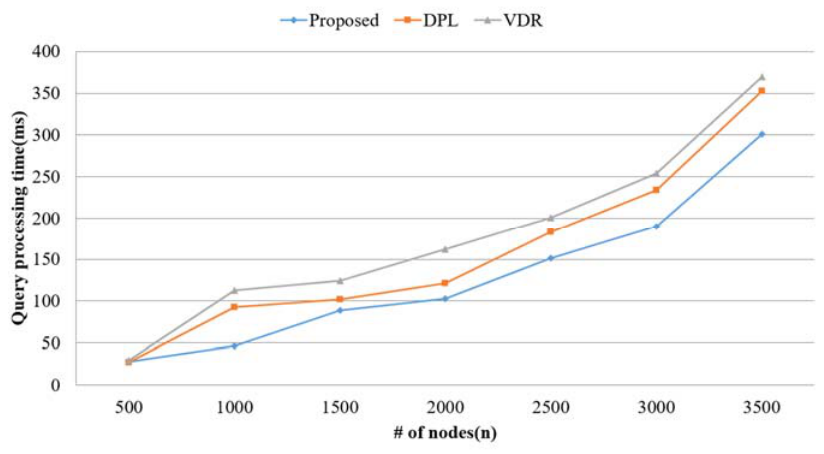
Figure 14. Query-processing time according to number of nodes. Figure 14. Query ‐ processing time according to number of nodes.